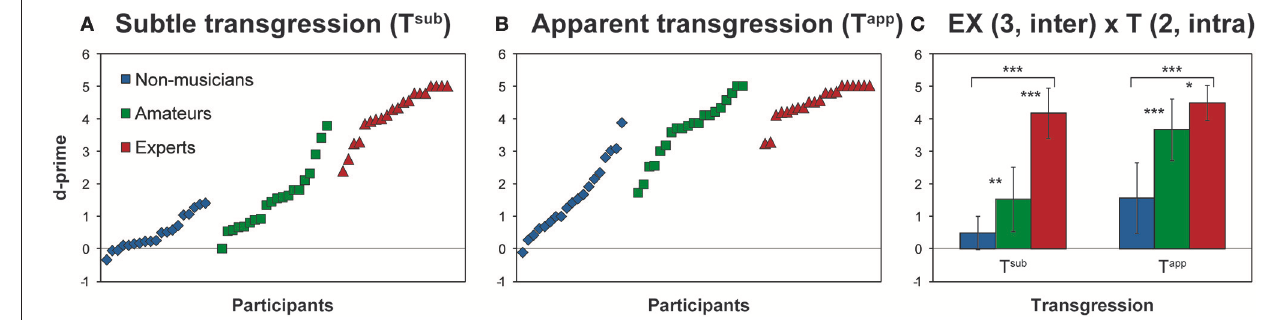
FIGURE 2 | Behavioral Results. (A,B) Show individual d-prime scores of all participants for T sub and T app , according to Expertise group; (C) depicts the mean d-prime scores for each group for both transgression conditions. The main effects of the ANOVA are provided in Table 2 . Asterisks indicate Bonferroni corrected contrasts between the groups. * p < 0.05, ** p < 0.01, *** p < 0.001.